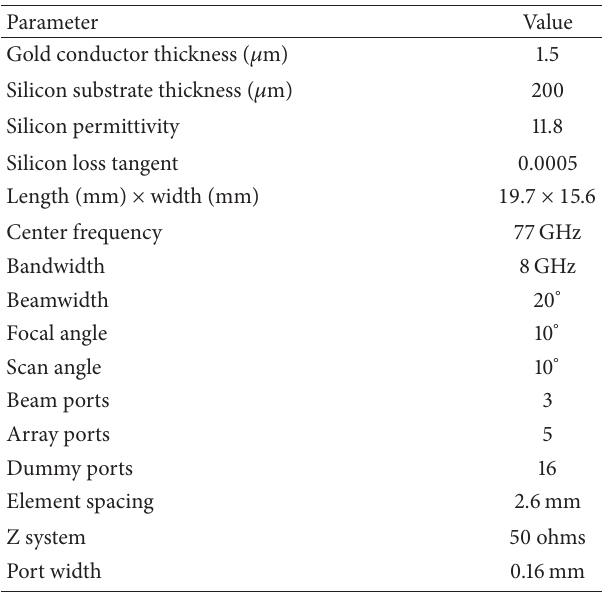
Table 1: Rotman Lens Design Specifications.